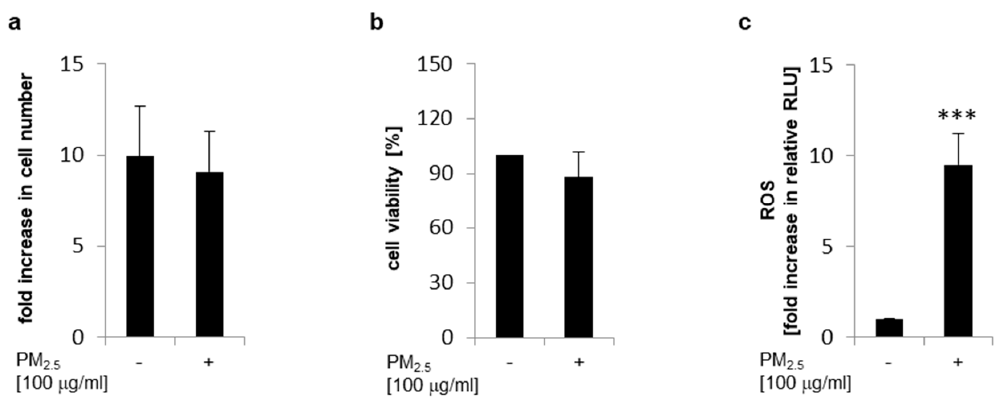
Figure 1. Long-term exposure to PM 2.5 does not affect proliferation or cellular viability but increases intracellular reactive oxygen species (ROS). BEAS-2B cells were cultured in the presence of 100 µg/mL PM 2.5 for three to five weeks as described in the materials and methods section. ( a ) Cells were detached by trypsin, analyzed by a trypan blue exclusion assay, and counted in a Neubauer counting chamber using a light microscope. Only viable cells were considered and were depicted as fold increase in cell number compared to plated cells (n = 3). ( b ) Cellular viability was determined by an MTT assay (n = 3). ( c ) For quantification of intracellular ROS, 2 ′ ,7 ′ -dichlorofluorescein diacetate (DCFH-DA) labeled cells were analyzed by flow cytometry (n = 3). Cells cultured in the absence of PM 2.5 served as controls. Values are depicted as means and +standard deviations; *** p < 0.001.